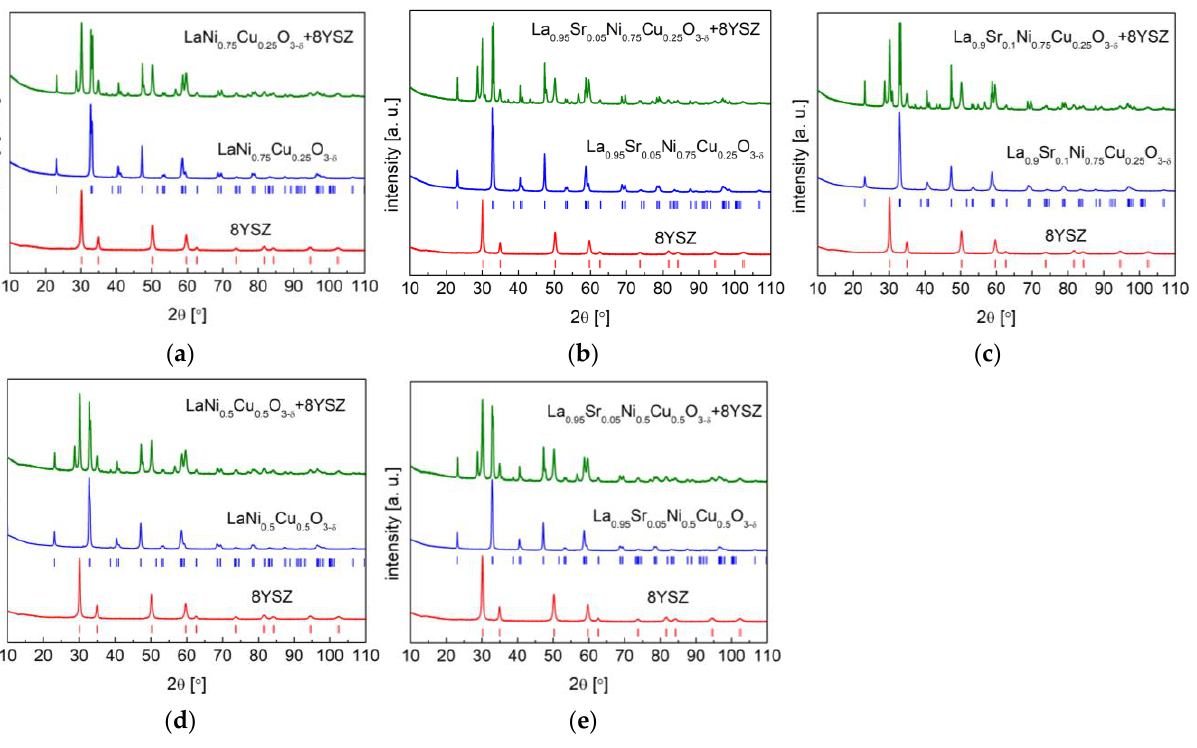
Figure 10. XRD diffractograms with Rietveld refinement of ( a ) LaNi 0.75 Cu 0.25 O 3−δ ; ( b ) La 0.95 Sr 0.05 Ni 0.75 Cu 0.25 O 3−δ ; ( c ) La 0.9 Sr 0.1 Ni 0.75 Cu 0.25 O 3−δ ; ( d ) LaNi 0.5 Cu 0.5 O 3−δ ; ( e ) La 0.95 Sr 0.05 Ni 0.5 Cu 0.5 O 3−δ with LSGM solid electrolyte after annealing in air at 800 °C for 100 h. Unfortunately, in the case of La 1−x Sr x Ni 1−y Cu y O 3−δ with the 8YSZ electrolyte (Figure 11), the considered cathode materials were not compatible with the studied electrolyte, presenting evident additional peaks, which limited the direct contact of the La 1−x Sr x Ni 1−y Cu y O 3−δ materials with 8YSZ in SOFCs. Therefore, for the anode-supported SOFC (Ni-8YSZ | 8YSZ | CGO10 | cathode) studied in the following section, a CGO10 buffer layer was applied to ensure a good and stable cell performance.